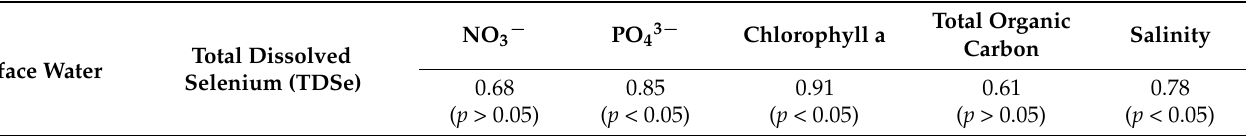
Table 7. Physical and chemical parameters correlation coefficient against total dissolved selenium in the surface and bottom water of Sharm Obhur ( n = 6